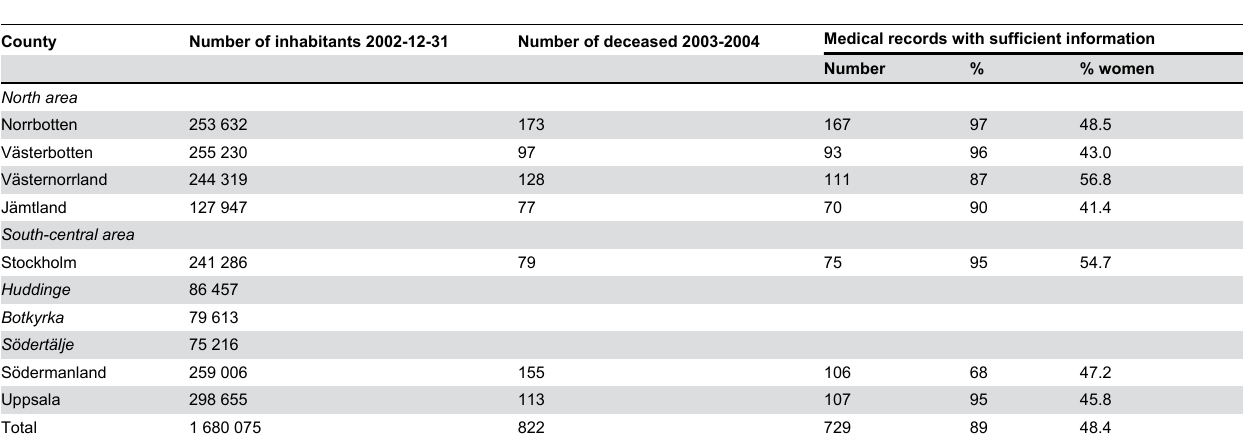
Table 1. Number of inhabitants December 31, 2002, number of deceased with COPD as the underlying cause of death 2003-2004 and number (%) of deceased 2003-2004 with medical records with sufficient information by county.